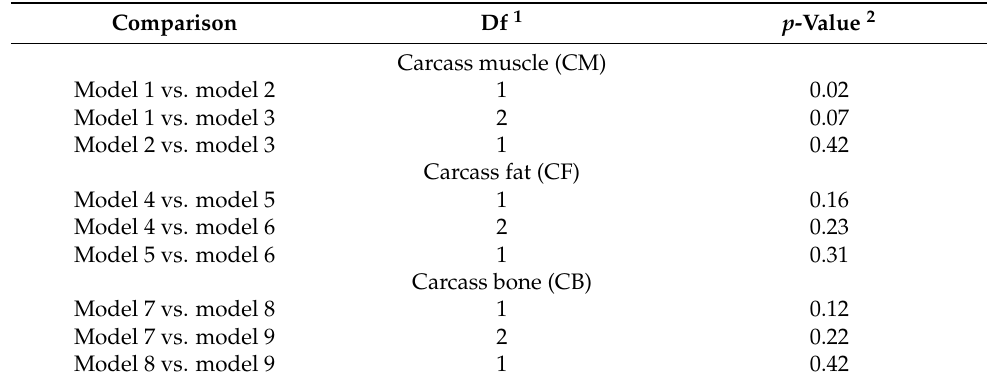
Table 5. Assessment of parsimony of the proposed